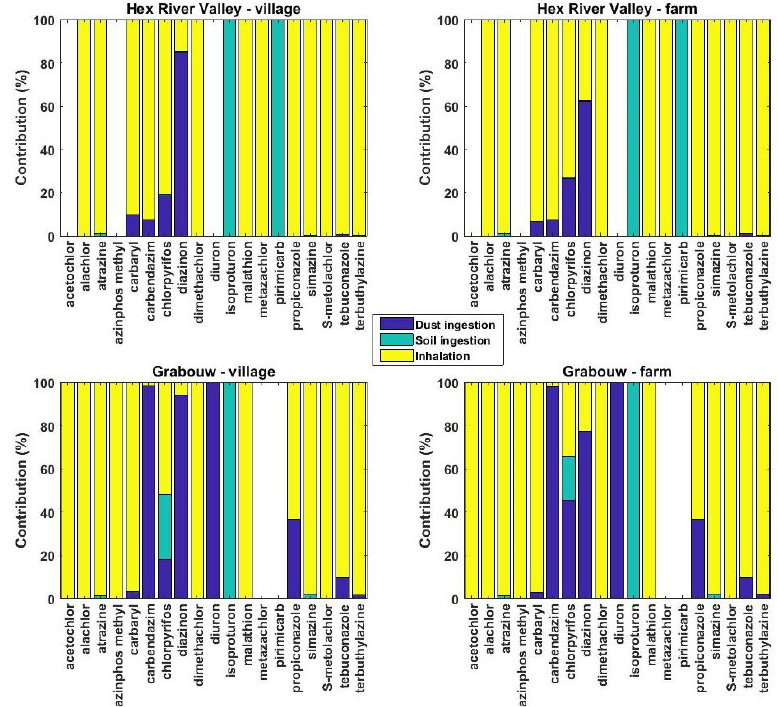
Figure 6. Contribution of three exposure pathways (dust ingestion, soil ingestion, and inhalation) on the daily uptake of pesticides of children living at farm and village locations at Hex River Valley and Grabouw using the median concentrations. Blank columns corresponds to the cases when a pesticide was not quantified in air, soil, and dust.